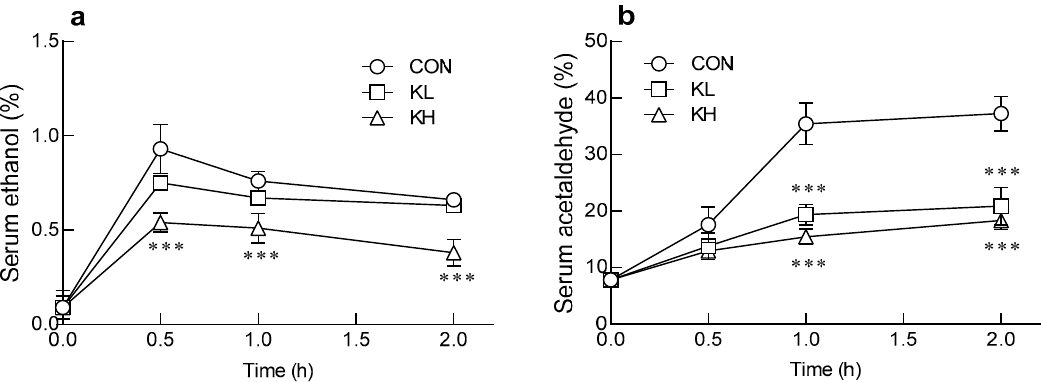
oxidation product, increased until 30 min after ethanol administration and remained high.